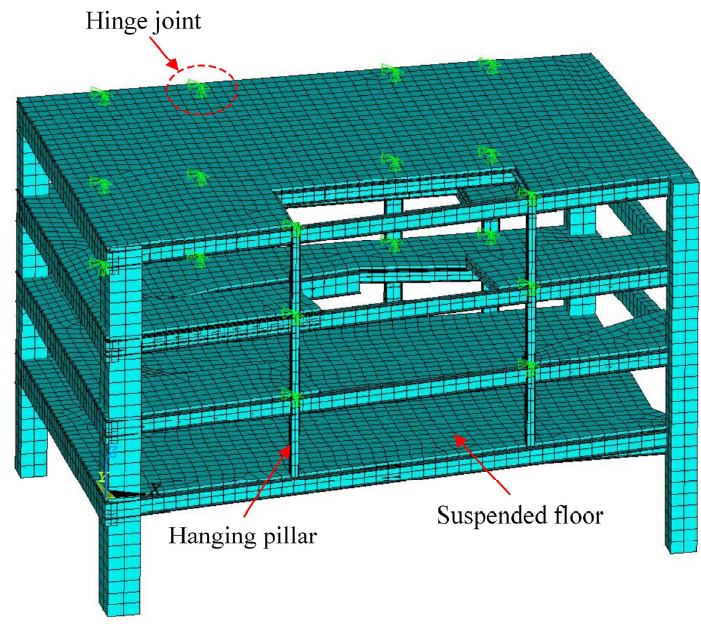
Figure 8. The overall FE model of the suspended floor in zone B.